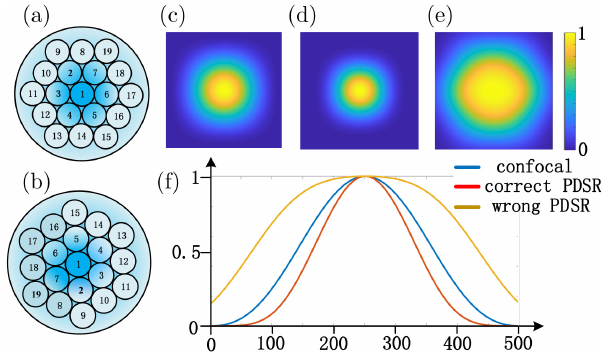
Fig. 2. Illustration of the reconstruction with correct shifting value and wrong shifting value. The ideal condition (a) and the practical condition (b) of the ¯ber in the setup. The PSF of confocal (c), correct reconstruction (d) and wrong reconstruc- tion (e). The normalized intensity pro¯le of cross-section through the PSF of confocal, correct reconstruction and wrong reconstruction (f). The color bar represents the normalized